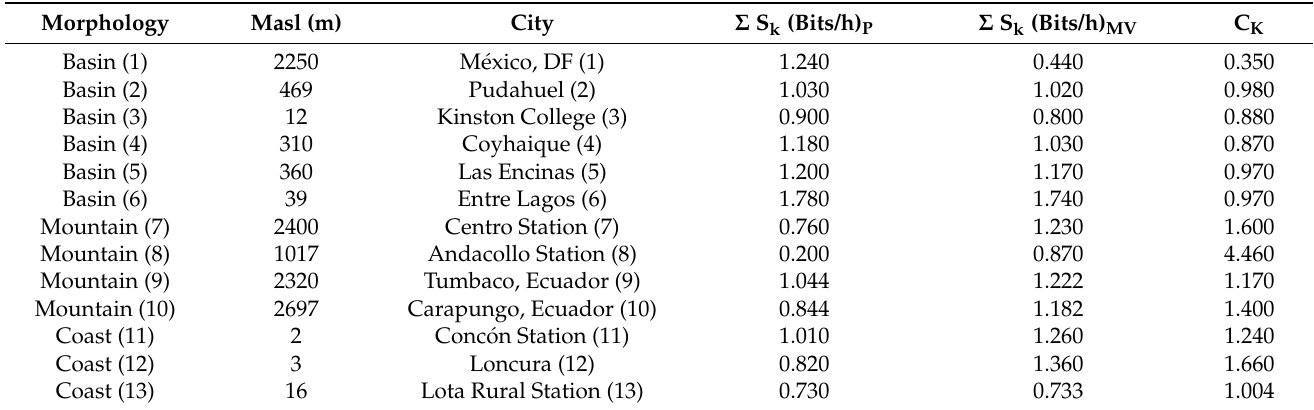
Table 6. Summary of the ratios between the sum of the entropies of meteorological variables and the sum of the entropies of pollutants, C K .